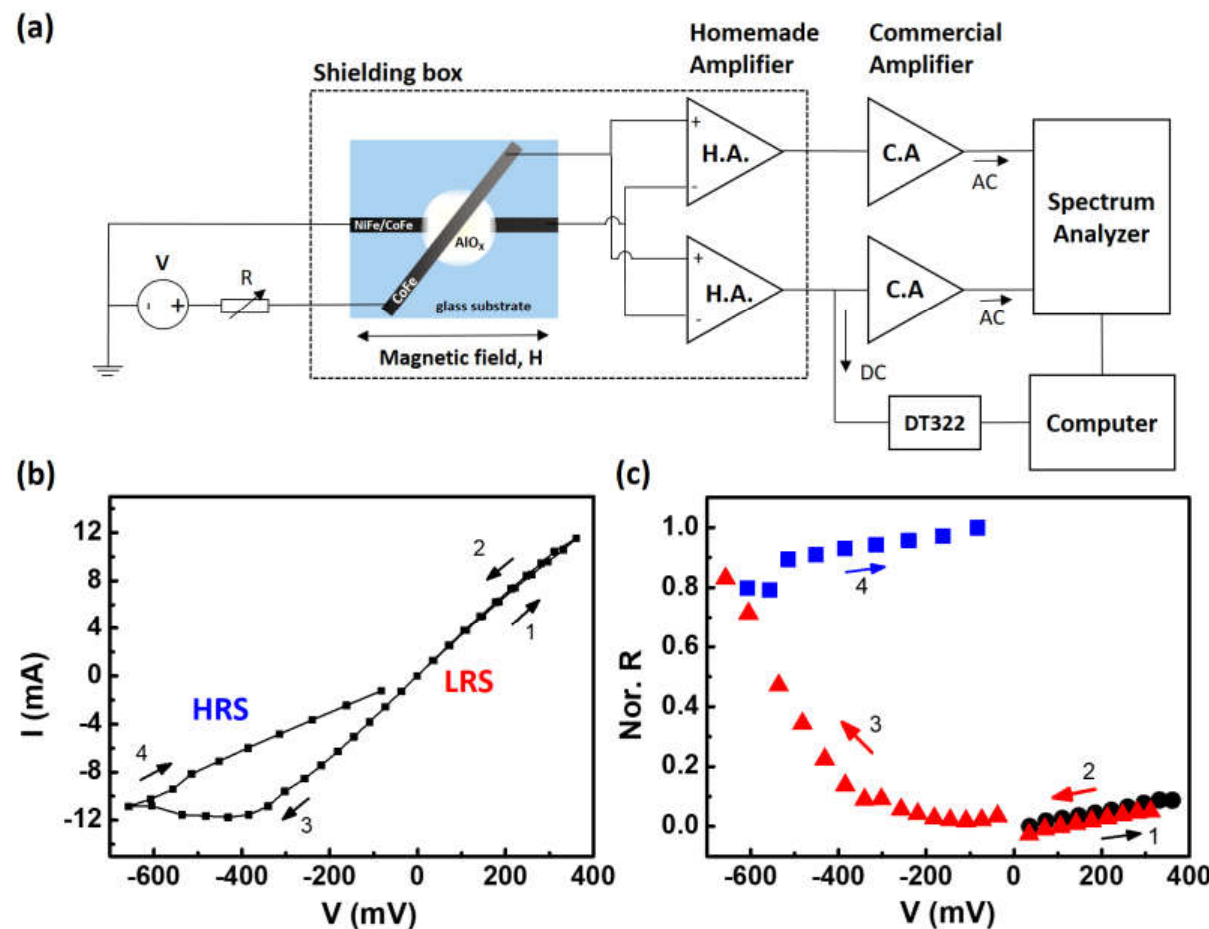
Figure 2. ( a ) Experimental setup for LFN measurements. The device and home-made preamplifiers were placed in a shielding box. ( b ) The I–V characteristics of the device with bias voltage in the range of − 650 mV to 360 mV. ( c ) Normalized junction resistance of a resistive memory device as a function of the applied bias voltage. In order to better understand the noise characteristics (see Figures 3 and 4), the device was intentionally controlled in the LRS by applying a positive voltage lower than the threshold setting voltage of ~0.6 V. The arrow shows the direction of the voltage sweep.